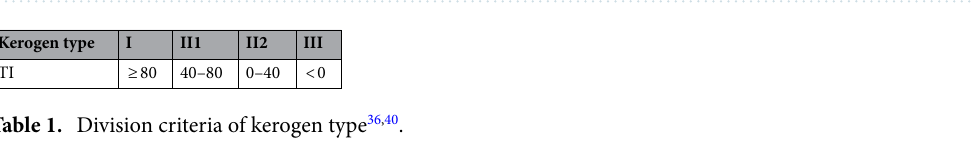
Table 1. Division criteria of kerogen type 36,40